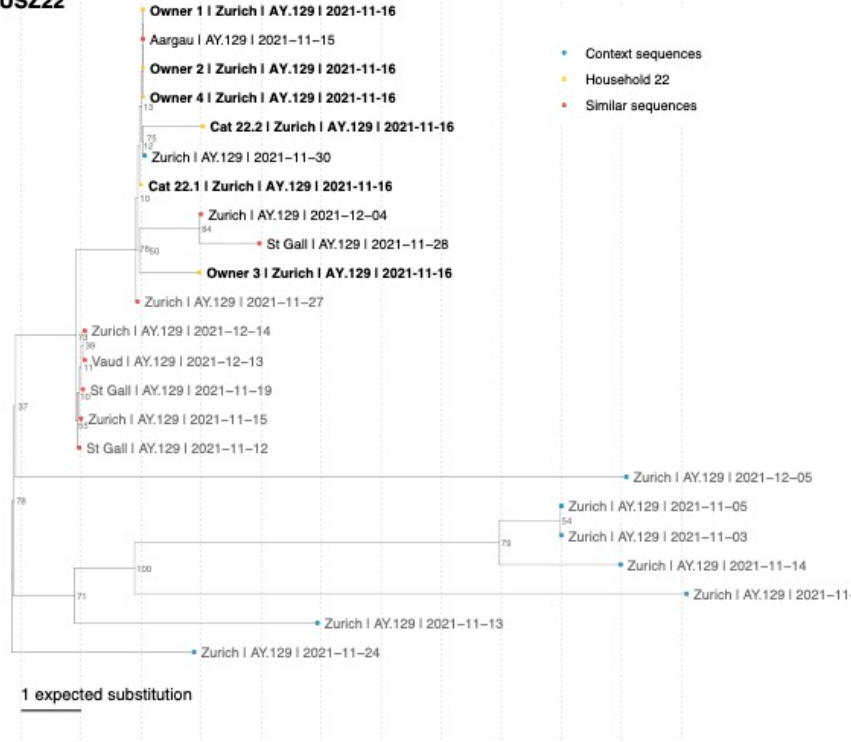
Figure A2. Maximum-likelihood phylogenetic tree showing the relationship between the six se- quences of USZ22 (yellow dots and bold text) and their respective 10 most genetically similar Swiss sequences obtained from GISAID. The most similar sequences (red dots) are defined as those with the smaller number of SNPs differences to each household sequence (sequences that are part of the 10 closest sequences for several of the household sequences only appear once in the tree). Blue dots indicate a representative set of 10 sequences circulating in Zurich in November 2021 from pangolin lineage AY.129 (context sequences). Location, pangolin lineage, and collection date are shown for each sequence. Bootstrap values for the internal nodes are shown next to each node from 10,000 bootstrap replicates. Branch length in the tree represents evolutionary distance, i.e., substitutions per site. Reference sequence Wuhan/Hu-1/2019 is used as an outgroup to root the tree.